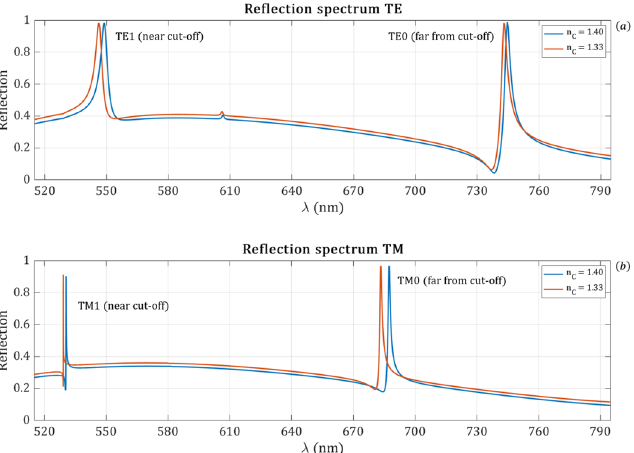
Figure 2. Simulated reflection spectra of the sensor for TE and TM excitation with d F = 185 nm and for two different cover refractive indices with an incidence angle of 26°. ( a ) The TE reflection spectrum of the sensor. The right peak corresponds to the TE 0 mode, while the left peak corresponds to the TE 1 mode. ( b ) The TM reflection spectrum of the sensor. The right peak corresponds to the TM 0 mode, while the left peak corresponds to the TM 1 mode. It can be seen that the resonant peaks are shifted due to the cover refractive index change but not only the wavelength shift of the TM 1 peak is smaller compare to the other resonant peaks but it became also